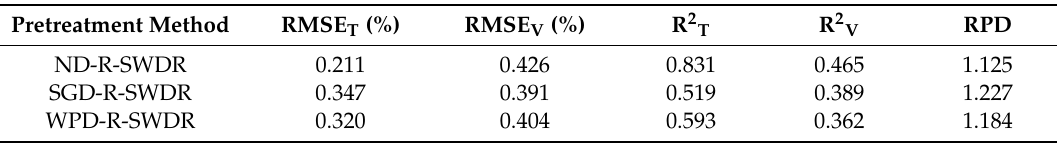
Table 7. Comparison of the SOM Content Estimation Results for the R Spectral Data Subjected to SWDR and the Different Denoising Methods.